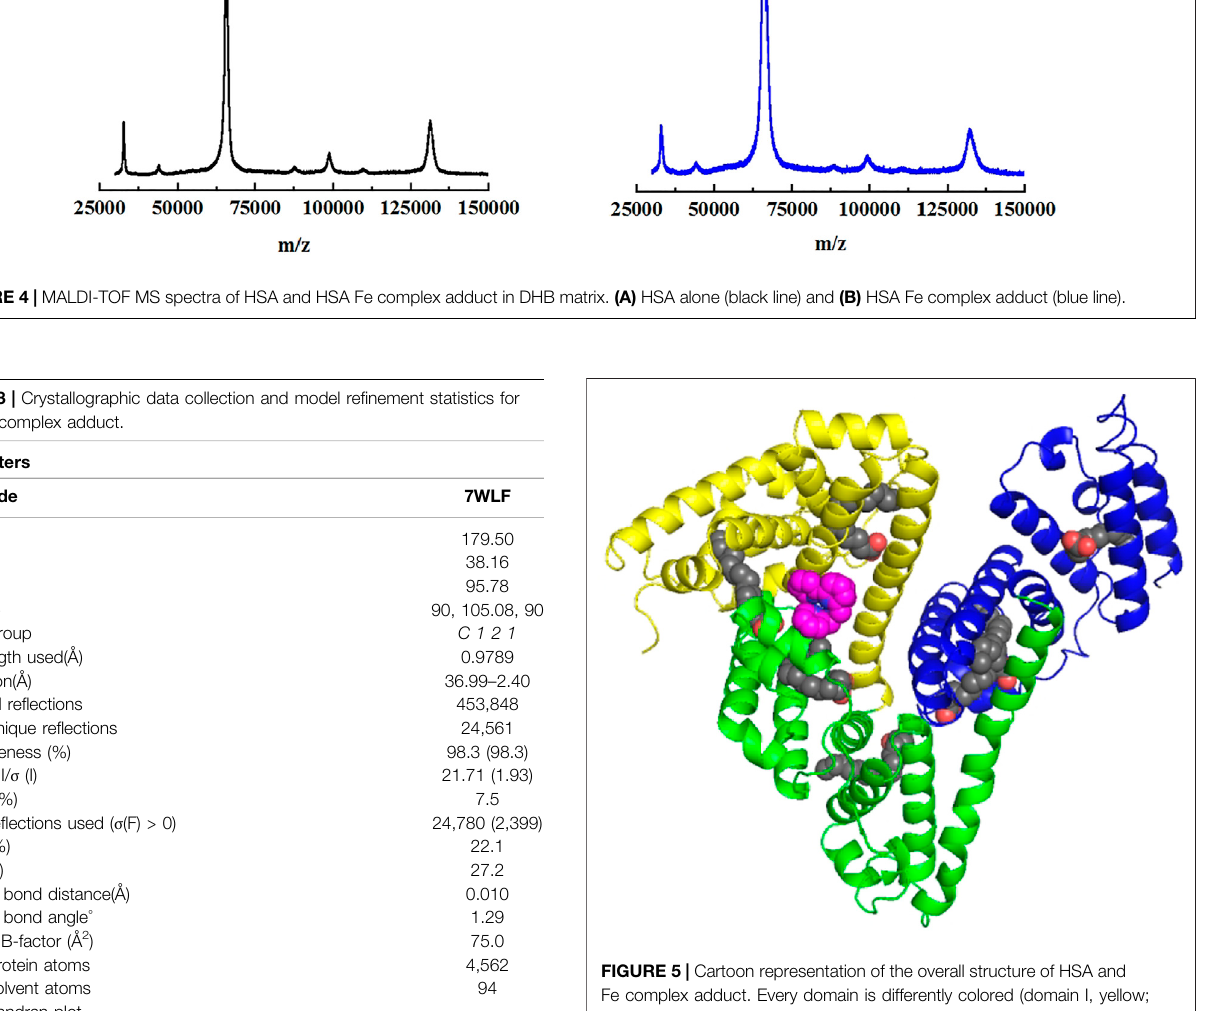
Figure 2 . The plasmid pBR322 DNA with different con fi gurations moves at different velocities in the electric fi eld.